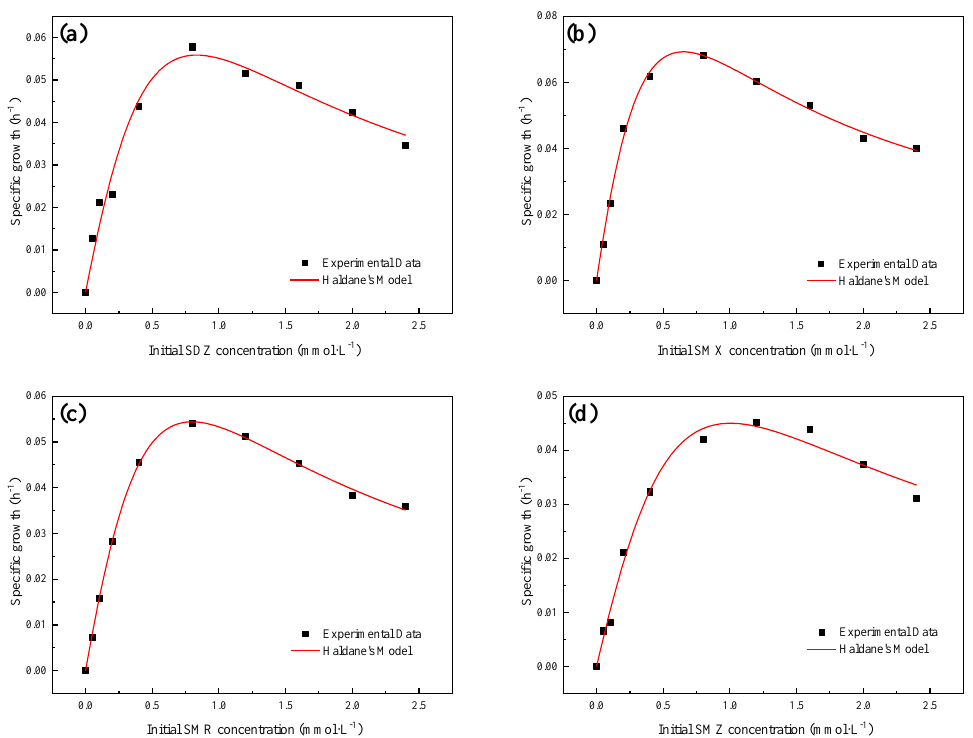
Figure 3. Experimental and predicted specific growth rates of strain YL1 against SDZ ( a ), SMX ( b ), SMR ( c ), and SMZ ( d ) according to the Haldane model.